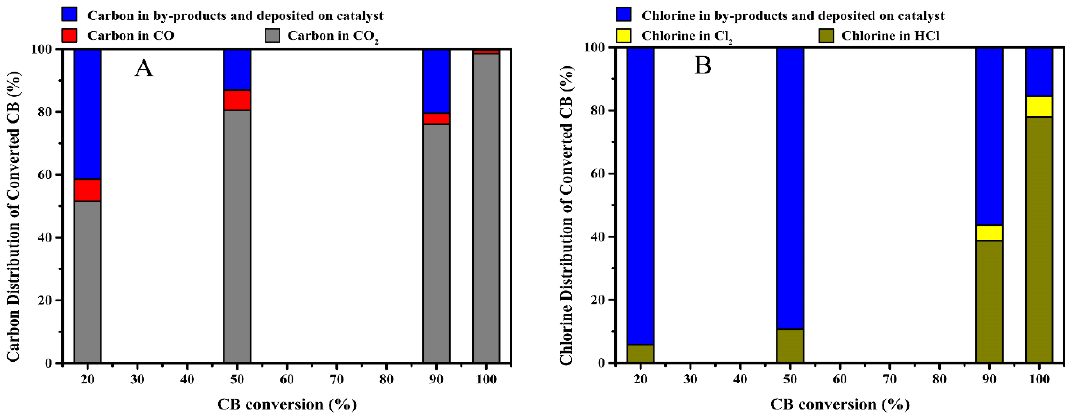
Figure 12. Carbon distribution ( A ) and chlorine distribution ( B ) of converted CB at different conversion rates over the MCZ-0.67 catalyst.